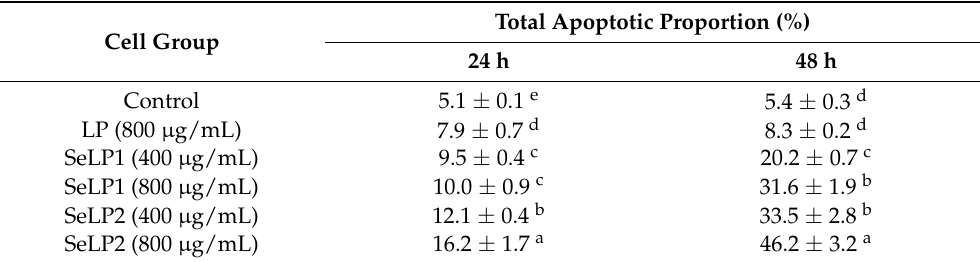
Different lowercase letters after the data as the superscripts indicate significant differences ( p <